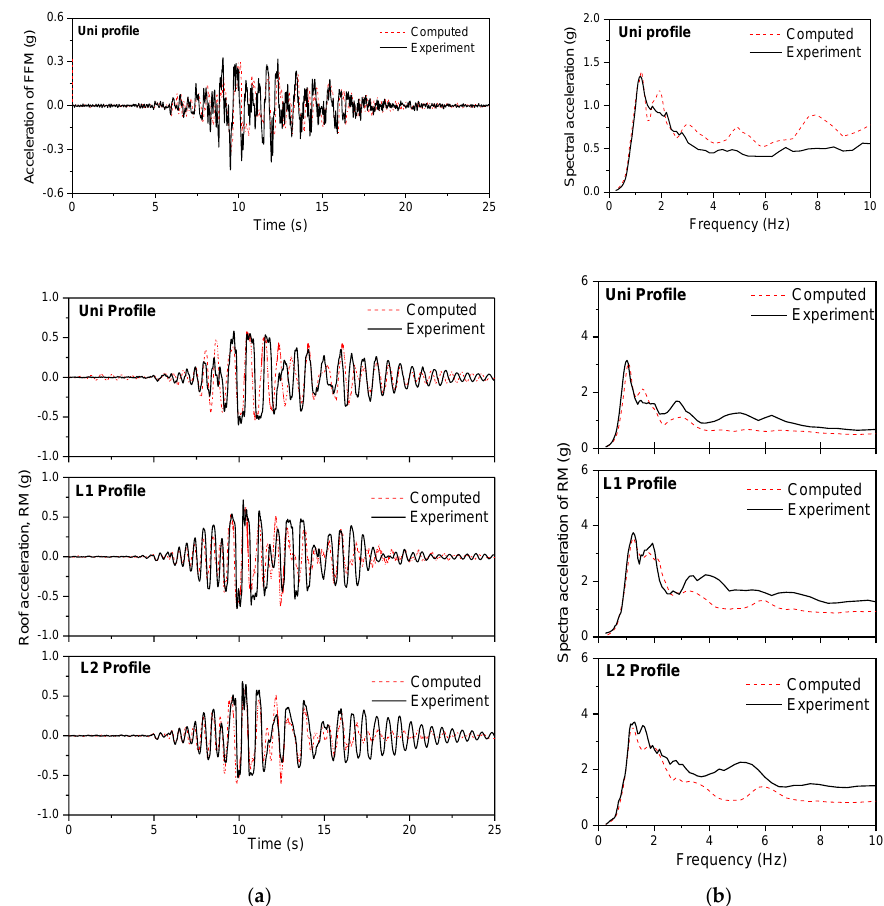
Figure 3. Comparison of computed results with the centrifuge test series for ( a ) acceleration and ( b ) response spectra.